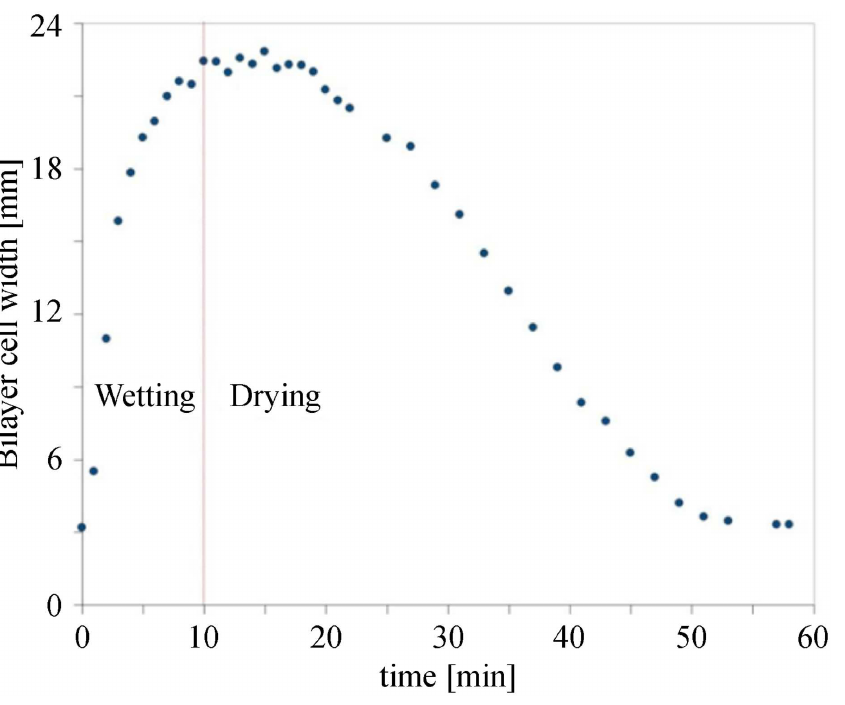
Fig 7. Reversible actuation of the bilayer-cell upon wetting-drying cycles. Opening and closing of a bilayer-cell upon wetting and drying at room temperature (50%RH) is plotted as a function of time.